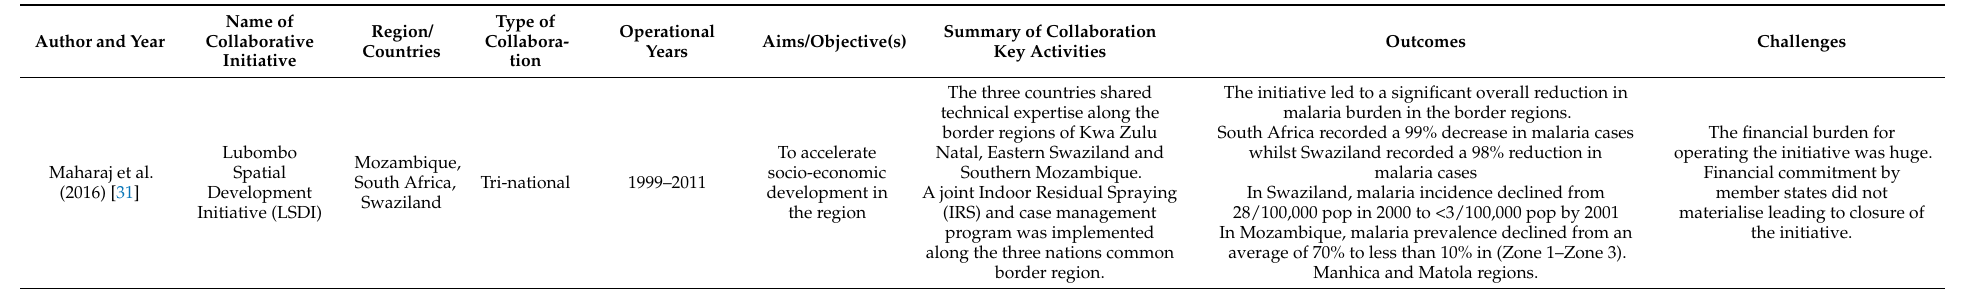
Table 1. Summary of articles and initiatives that were